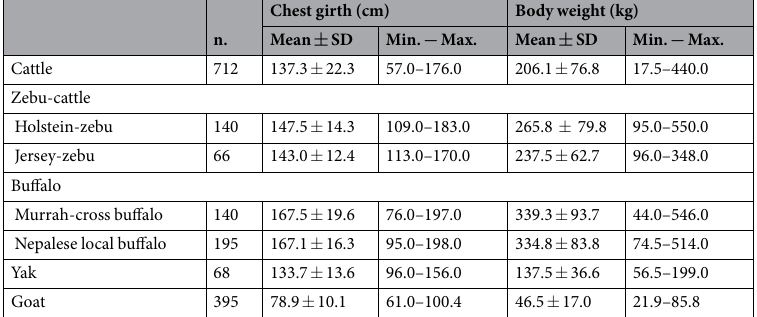
Table 1. Descriptive statistics of the data sets used for the